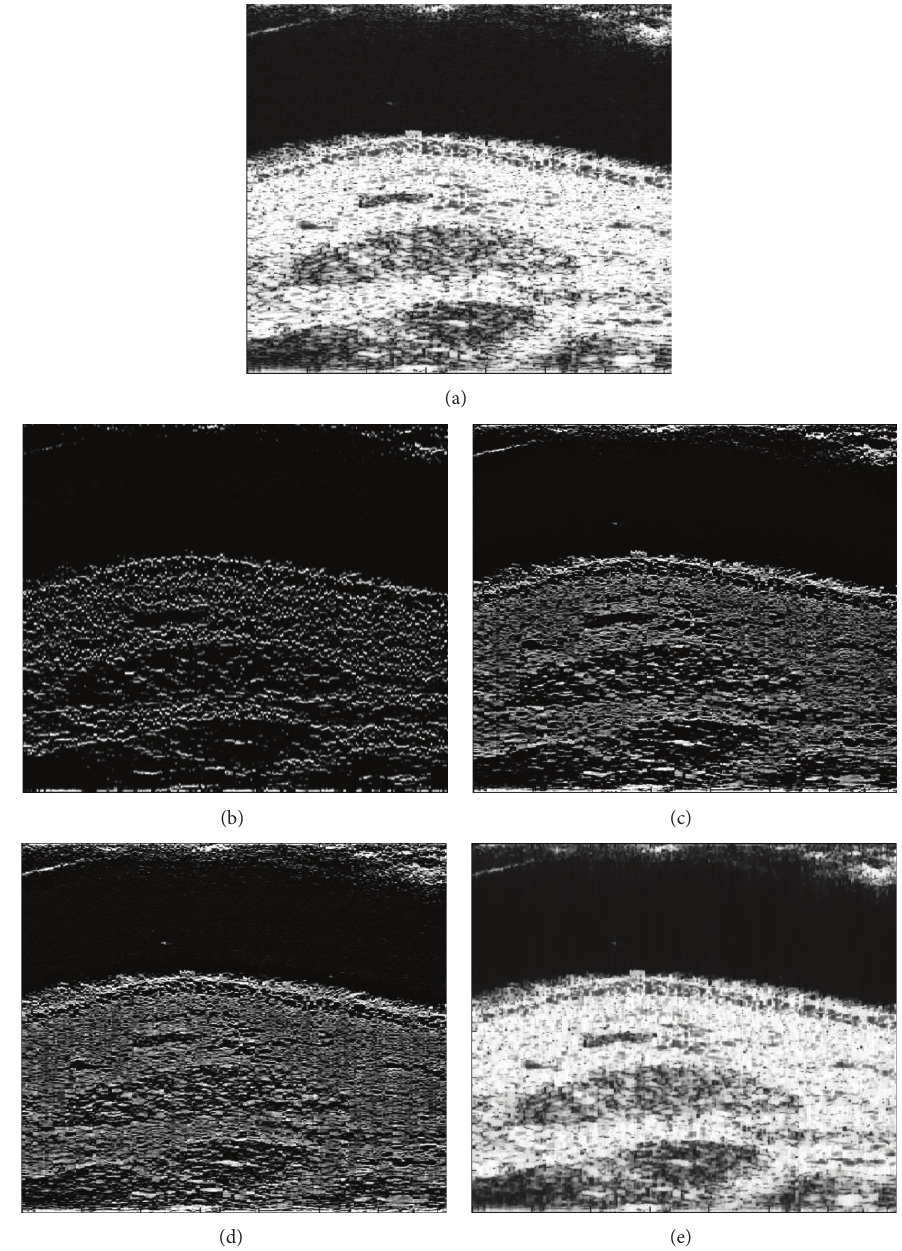
Figure 4: (a) Original data; (b) proposed method; (c) 𝑙 1 -norm method; (d) Wiener filtering; and (e) TV-norm